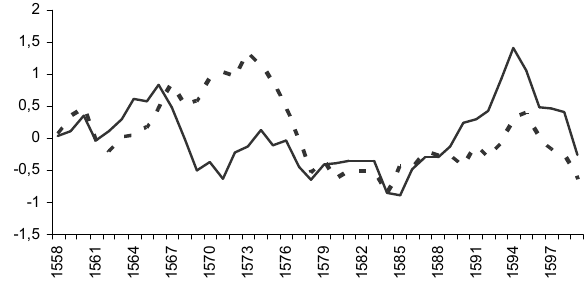
Figure 2. Standard five-year moving average curves of floods (solid line) and precipitation (broken line) in the Tagus basin . Y-axis = deviation from normal value; X-axis = years.